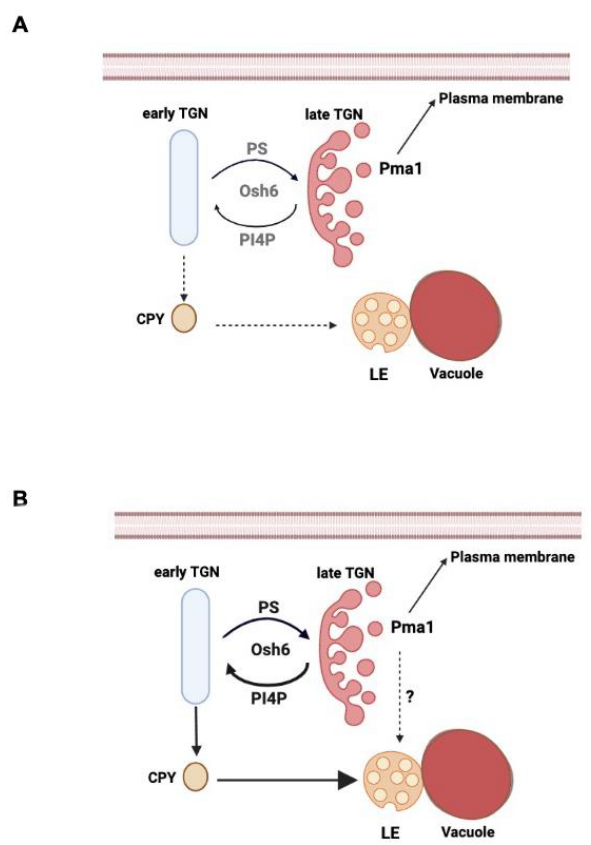
FIGURE 7: A working model for Osh6’s role in TGN -LE